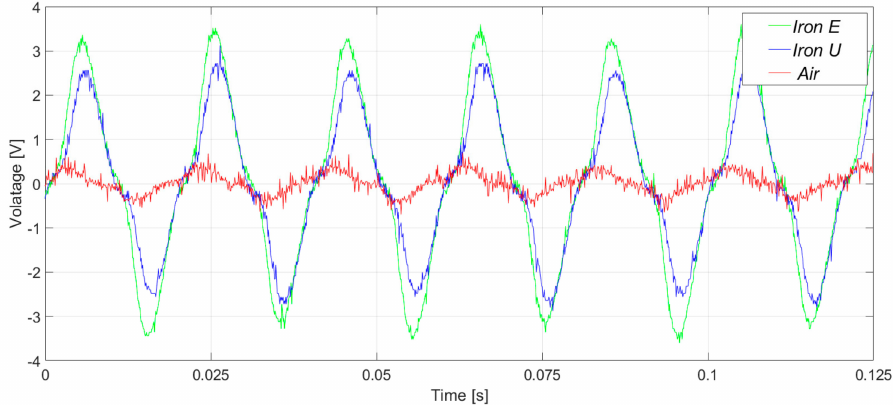
Figure 9. Induced voltage measurement in healthy conditions, in the upside position.